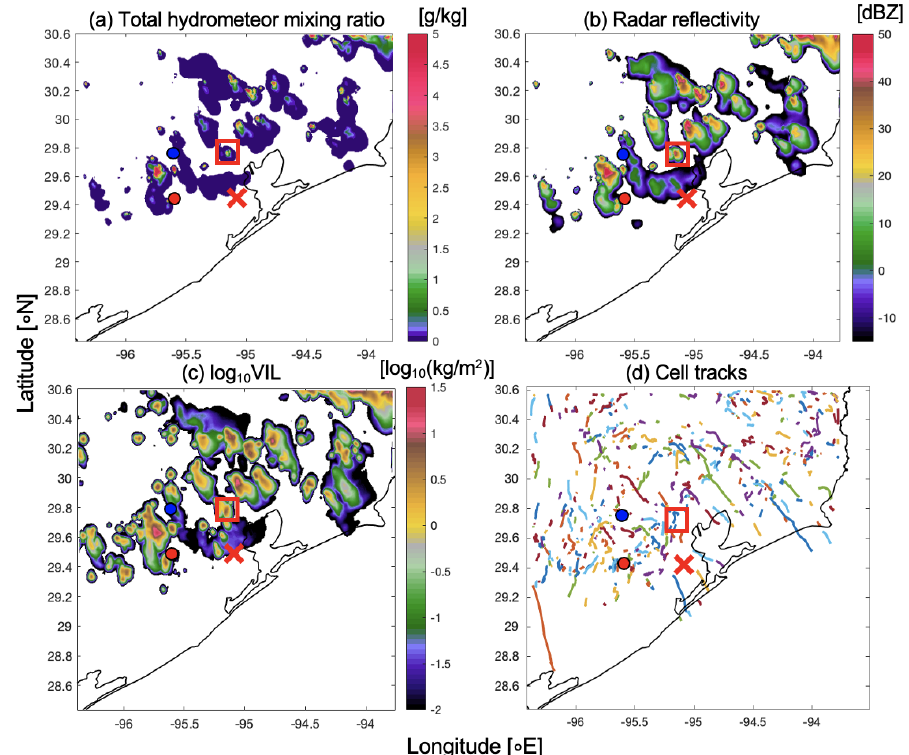
Figure 1. (a) A snapshot of the RAMS-simulated total hydrometeor condensate field at 21:09UTC at 5.5kma.s.l. (b) CR-SIM simulated radar reflectivity field at the same height and same time as (a) . (c) Vertically integrated liquid (VIL) estimated from the CR-SIM C-band total reflectivity (from total liquid and ice hydrometeor condensate) at the same time as (a) . (d) Tracks of precipitating convective cells detected between 20:00 and 23:59UTC using tobac . In each panel, the red X marks the location of a radar performing 5min VCP (i.e., NEXRAD KHGX), the red solid dot represents the location of a radar performing a different 5min VCP or RHI, and the blue solid dot represents the location of another radar performing RHI. The red rectangle represents the tracked cell of interest used for multi-Doppler radar retrieval and polarimetric evolution